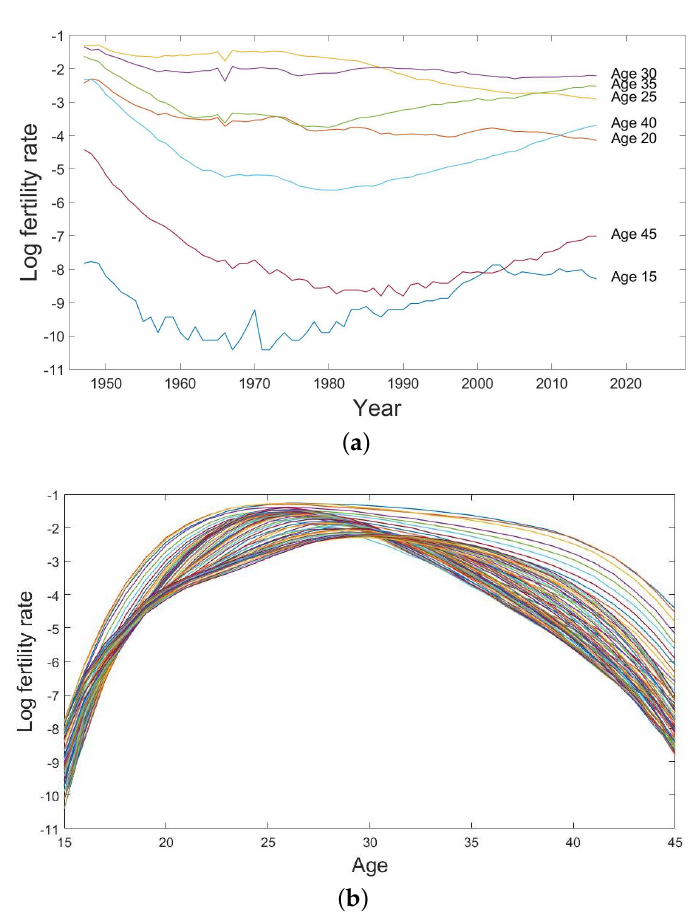
Figure 2. ( a ) Univariate time series of the log fertility rates with 5-year age intervals and ( b ) the log fertility curves from age 15 to age 45 from the year 1947 to the year 2016 in